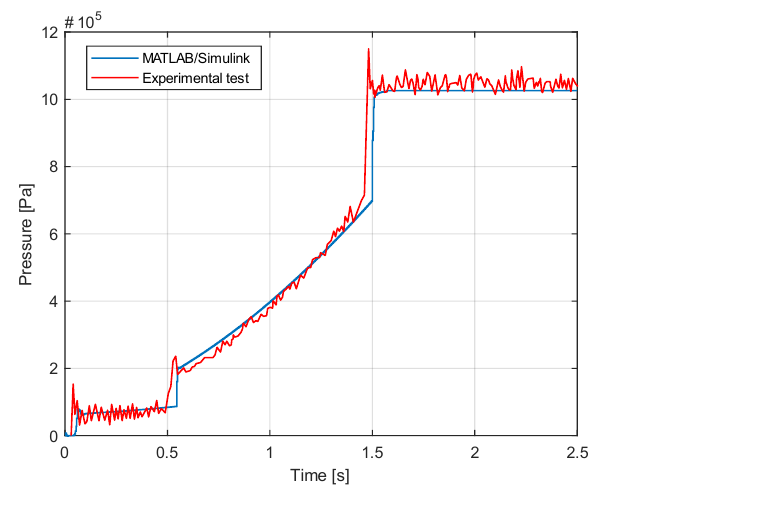
Figure 8 – Comparative presentation of the obtained results - T1 Рис. 8 – Сравнительный обзор полученных результатов – Т1 Слика 8 – Упоредни приказ добијених резултата ‒